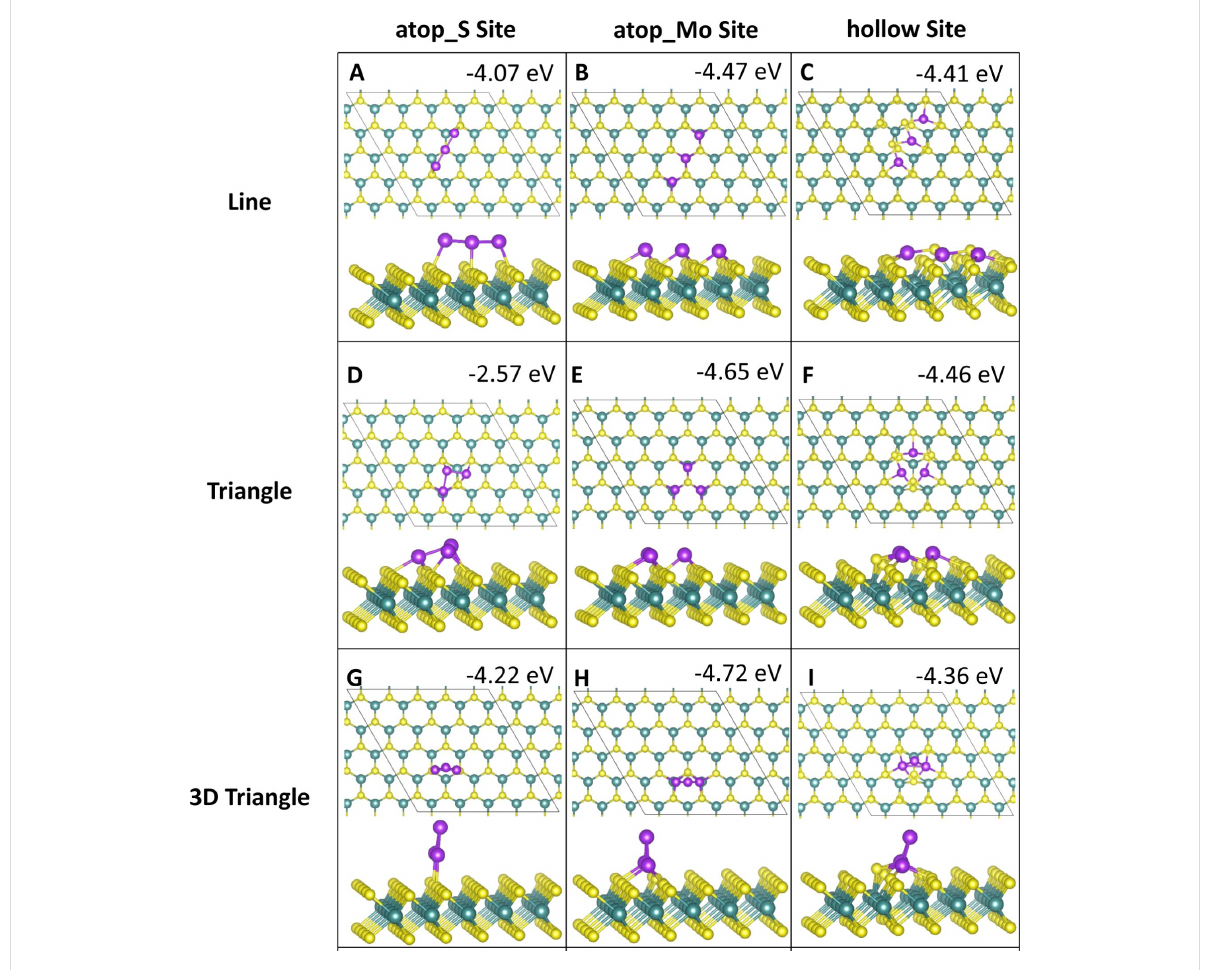
Figure 6: Atomic structure and energies of Ru 3 adsorption modes on perfect MoS 2 .